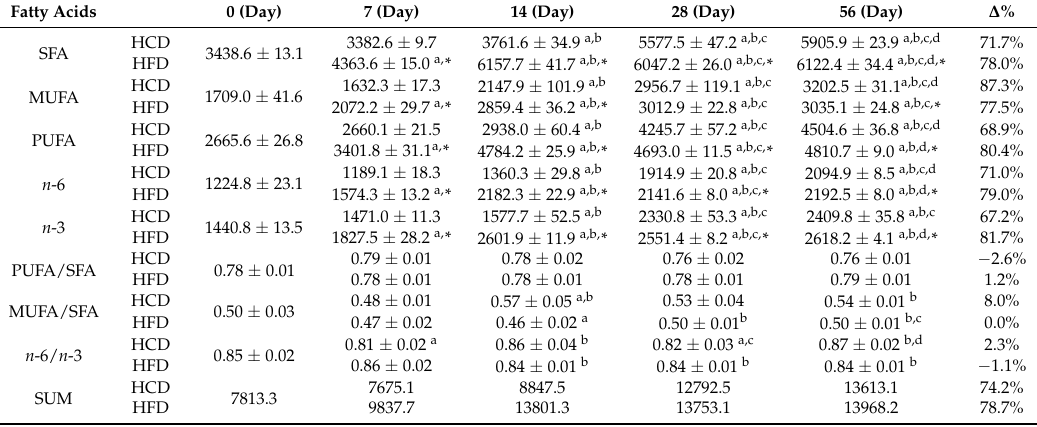
Table 2. Fatty acid family composition (mg/100 g of sample) and n-6/n-3 fatty acid, PUFA/SFA, and MUFA/SFA ratios in the brains of mice fed a high carbohydrate diet (HCD) or high fat diet (HFD) before (day 0) and 7, 14, 28, or 56 days after onset of diet administration. Key: ∆ %: percentage of change.